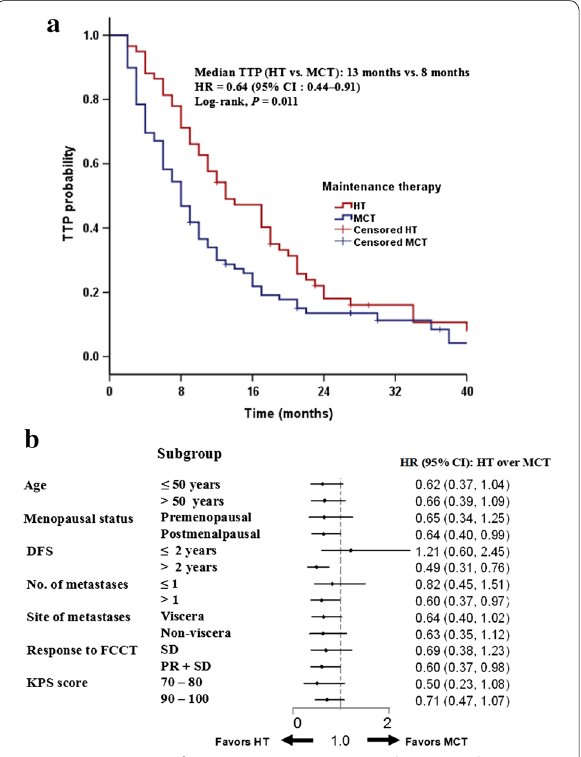
Fig. 1 Comparison of time to progression (TTP) between the HT group and the MCT group. a Estimation of TTP, censored on the date of last assessment. b Forest plot (TTP analysis); HR < 1 favors HT. DFS disease‑free survival, FCCT first‑line capecitabine‑based combina‑ tion chemotherapy, KPS Karnofsky performance status, CR complete response, PR partial response, SD stable disease, HT hormonal